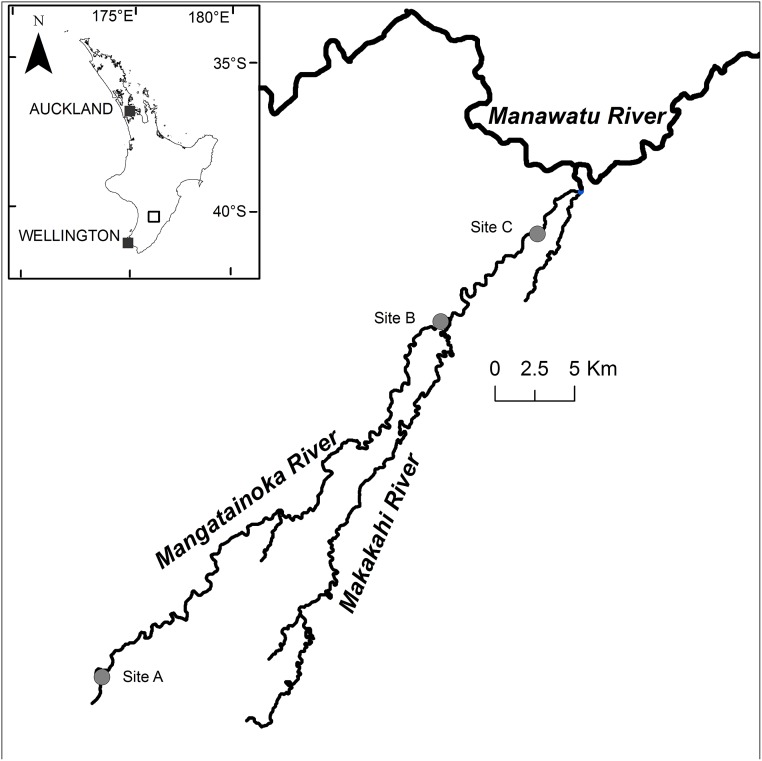
Location of study site (B) and sediment traps sites (A, B and C) in the Mangatainoka River, New Zealand.